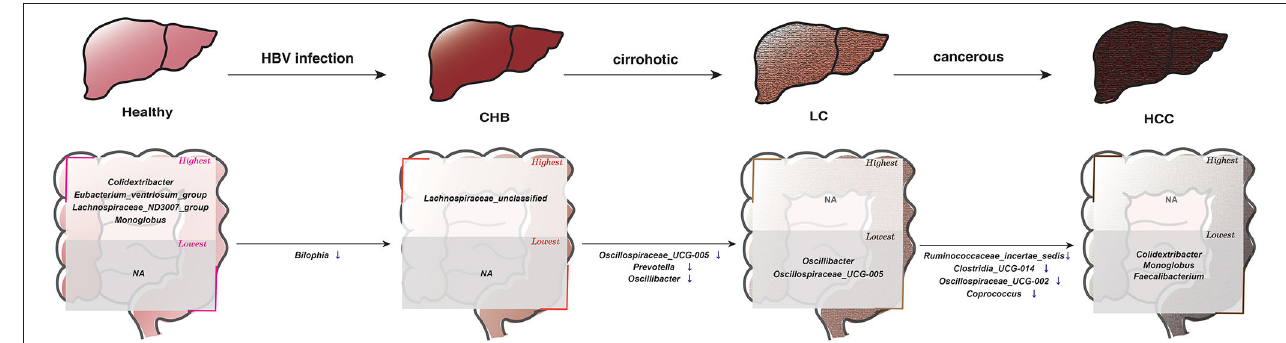
FIGURE 5 | The consistent microbial signatures along the progression of the HBV-induced diseases based on results in this study. The genera in the “highest” box denote that their average relative abundances were most enriched in the corresponding subgroup compared to all other subgroups, whereas those in the “lowest” box represent that their abundance were most depleted in the corresponding subgroup. In the progression from 1 disease stage to another, ↑ denotes significantly increased abundance, ↓ denotes significantly decreased abundance.